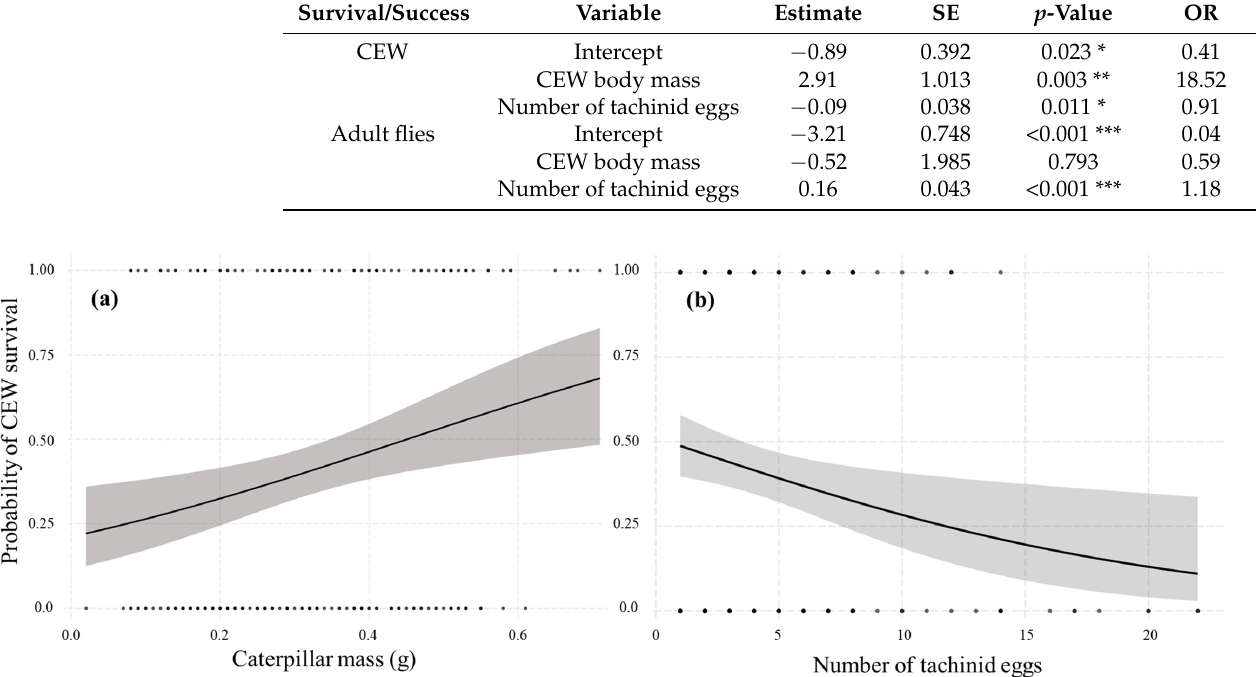
Figure 5. Predicted probability of CEW survival with respect to body mass ( a ) and number of tachinid eggs per host ( b ). Grey areas indicate the standard error. Table 3. Summary of the logistic regression models explaining the survival of CEW and success of tachinid flies (emergence of adults). SE = standard error, OR = odds ratio. Significant at 0.01 (*), 0.001 (**), <0.001 (***).